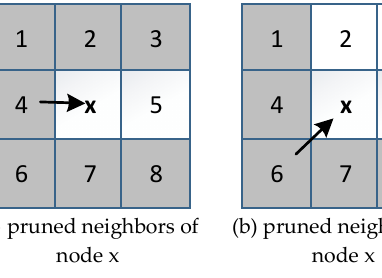
Figure 9. Neighbor Pruning and Forced Neighbor.